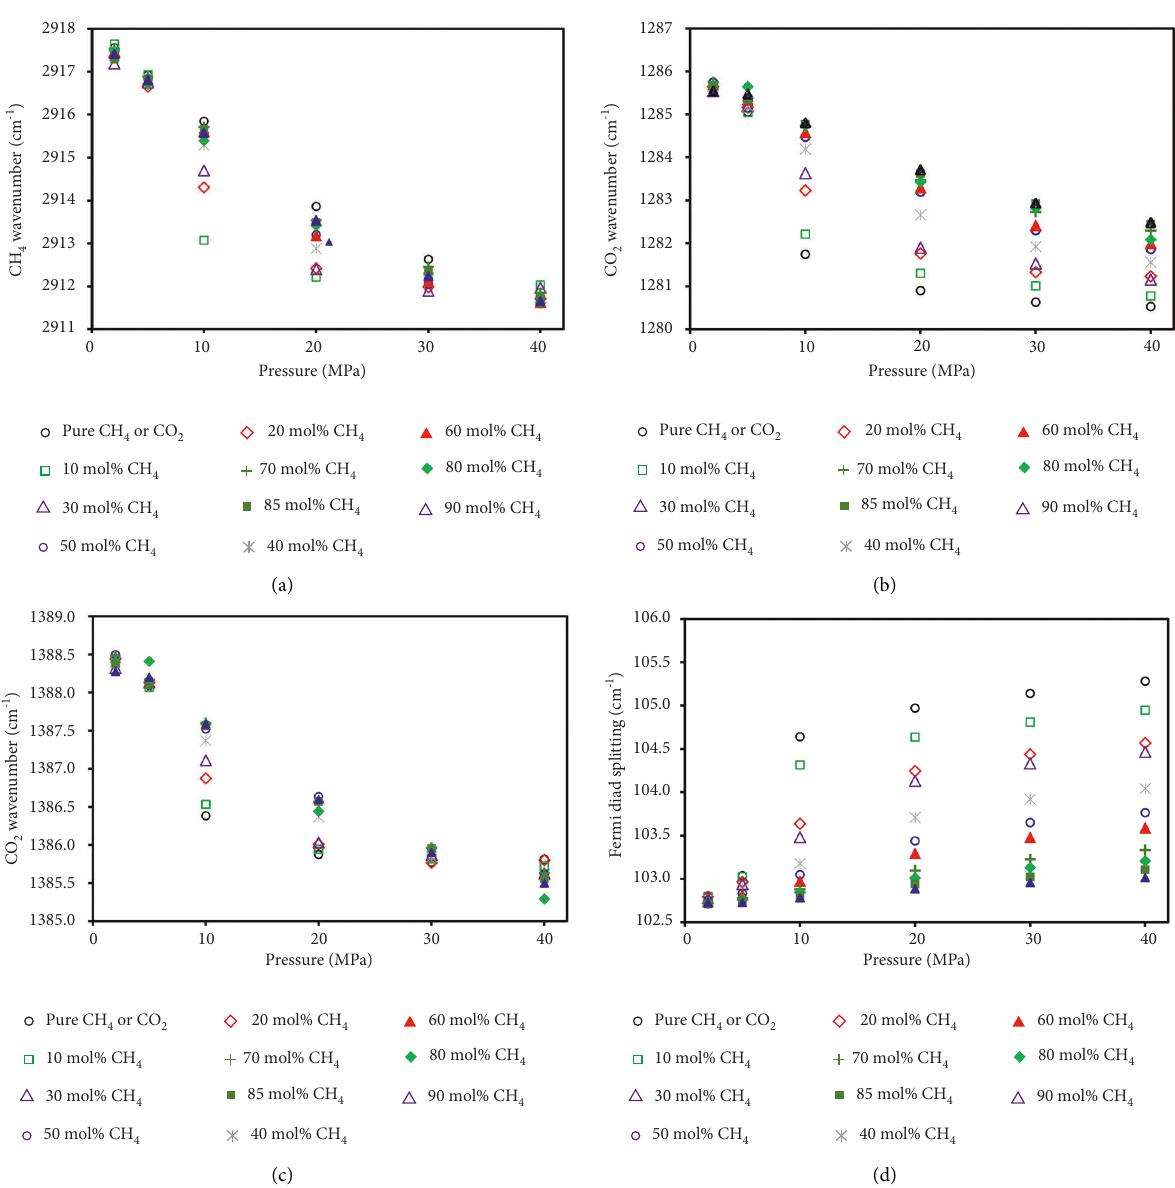
Figure 3: Raman peak positions for the CH 4 υ 1 peak (a) and the lower (b) and upper (c) members of the CO 2 Fermi diad and the Fermi diad splitting (d) for different CO 2 -CH 4 gaseous mixtures at room temperature as a function of